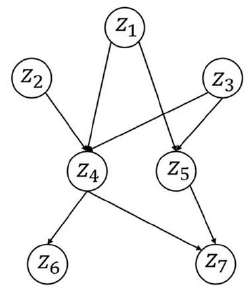
Figure A1 . An example of a Bayesian network. Figure A1. An example of a Bayesian